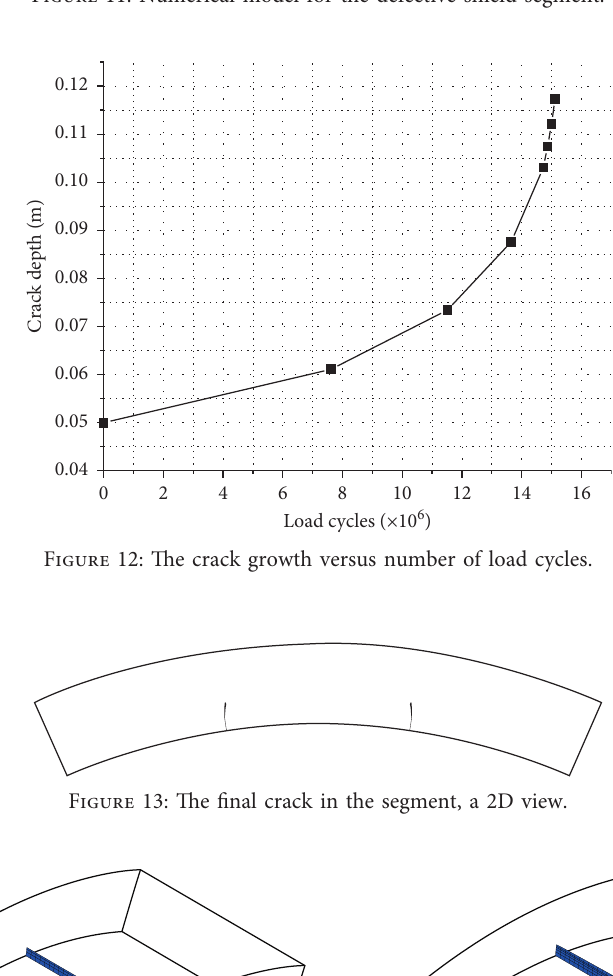
Figure 11: Numerical model for the defective shield segment.